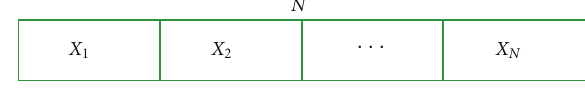
Figure 6: Input vector.